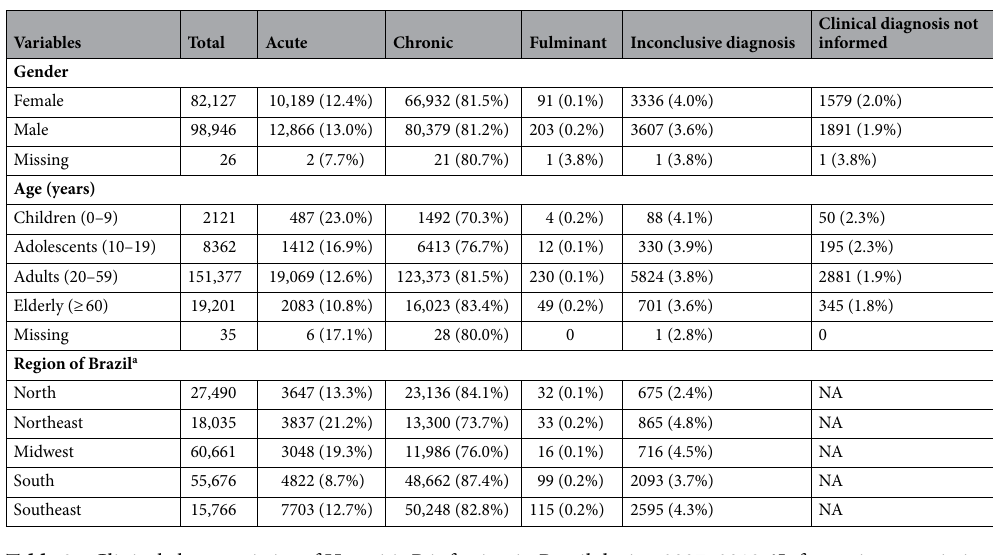
Table 3. Clinical characteristics of Hepatitis B infection in Brazil during 2007–2018. a Information on missing cases related to clinical HBV forms per regions of Brazil was not available. NA not available.